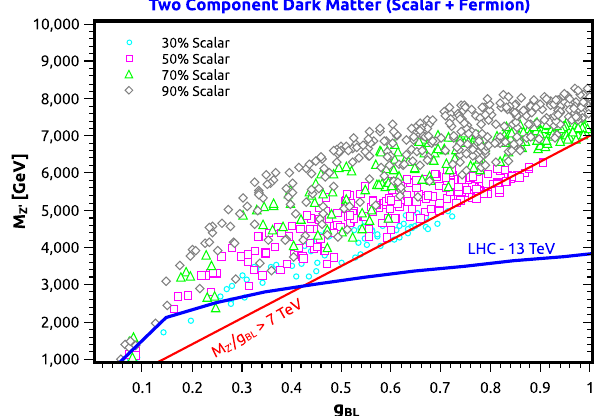
Fig. 15 Scan of the parameter space, in which a two-component dark matter scenario can be successfully realized and account for the entire dark matter of the Universe in agreement with direct detection limits. We have superimposed limits from the LHC ( blue curve ) and LEP ( red curves ). The points with different shapes represent different scalar dark matter contributions to the overall dark matter abundance. Blue circles represent the scenario where the scalar makes up for 30% of the total abundance; pink squares correspond to 50% of the total abundance; green triangles correspond to 70% of the total abundance; and gray diamonds correspond to 90% of the total